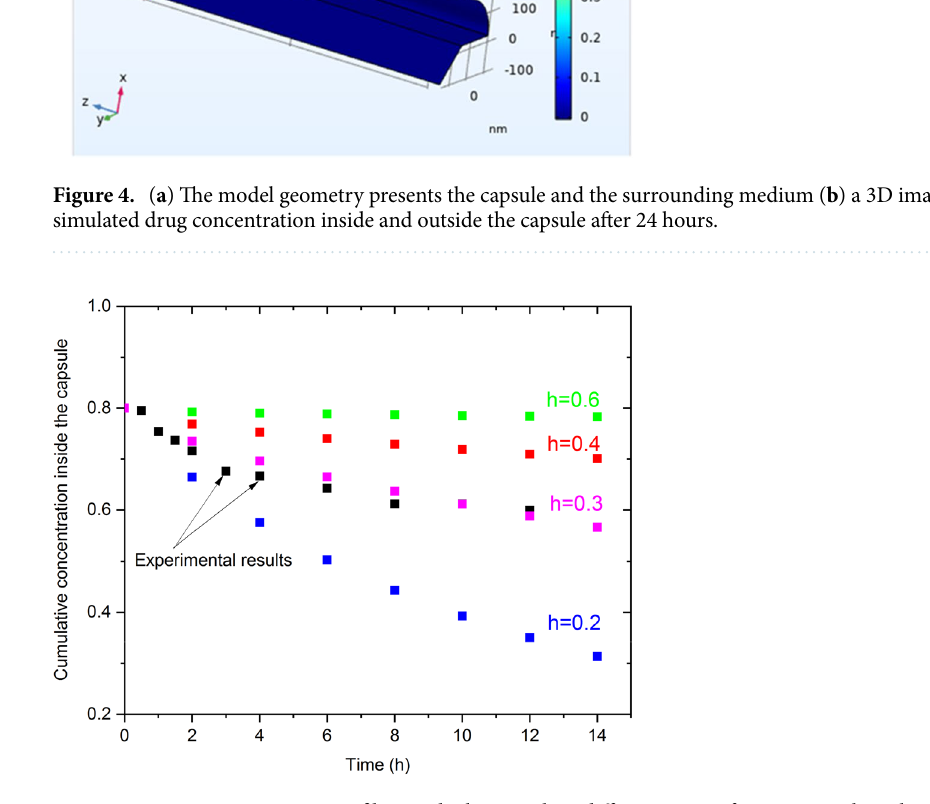
Figure 5. Drug concentration profiles inside the capsule at different times of experimental results and simulated data for different values of